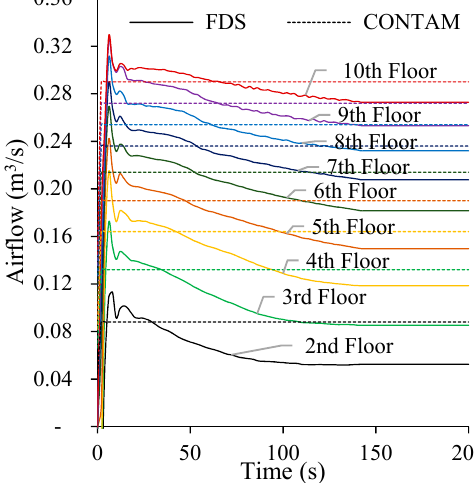
Figure 17. Airflow through stairwell doors for 1 st floor openings in FDS and CONTAM.